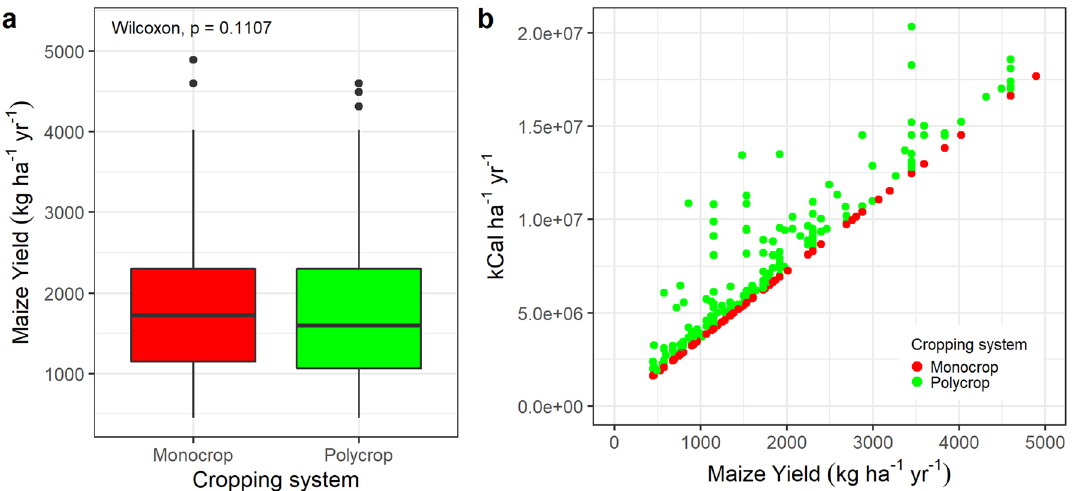
Figure 3. Maize yield ( a ) and total caloric yields vs maize yield ( b ) under maize monocrop and milpa systems (polycrop) in the Western Highlands of Guatemala.